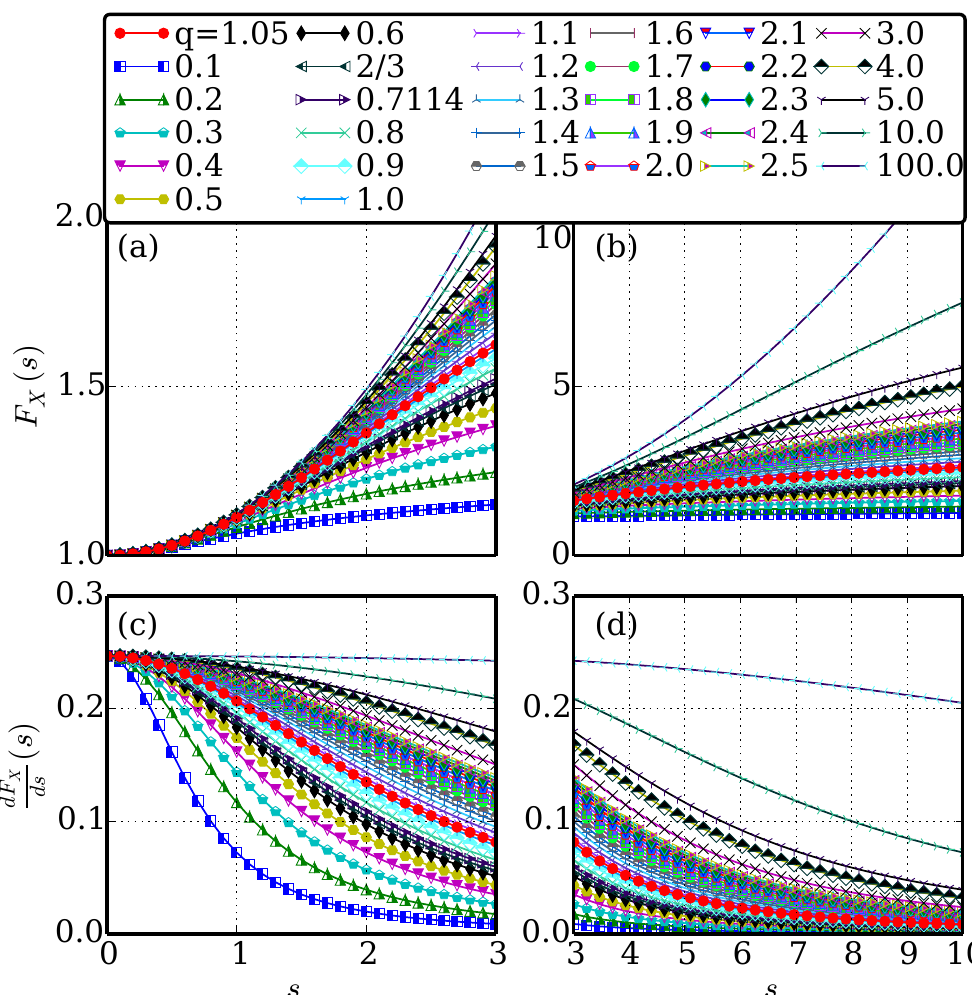
Figure 3. q dependent enhancement factor. The comparison of the exchange enhancement factor F X ( s ) in exchange energy functionals in the vdW-DFq method for various q values. The reduced density gradient s is in the range of ( a ) 0–3 low-gradient domain and ( b ) 3–10 high-gradient domain. The B86q and B86R denotes the case of q = 1.05 and 0.7114 respectively. The d ( c ) 0–3 and ( d )